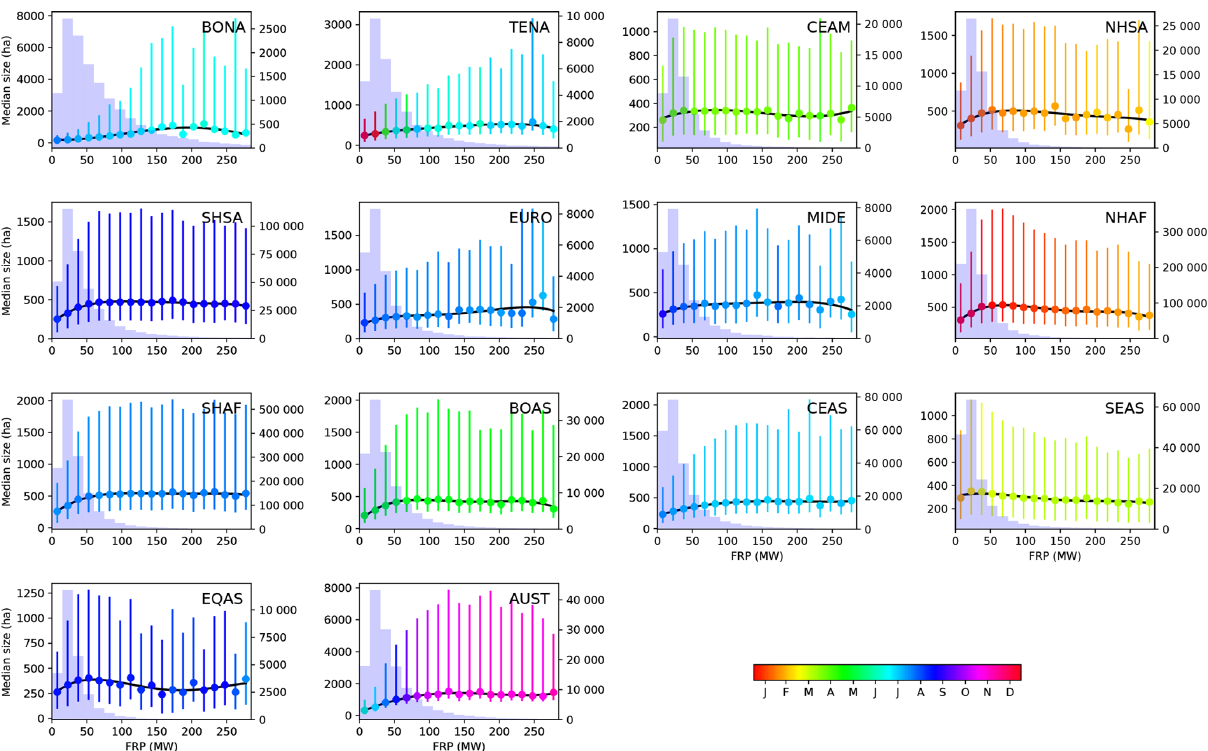
Figure 2. Median fire size vs. fire radiative power (FRP in megawatts) for different GFED regions. The error bars represent the 25th and 75th quantiles of the FS distribution. The colour of the dots and error bars represents the mean burn date of fire patches in each FRP bin. The black line shows the interpolated four-degree polynomial used to smooth the value of FRP associated with maximum median fire size. The background histograms represent the number of fire patches in each FRP